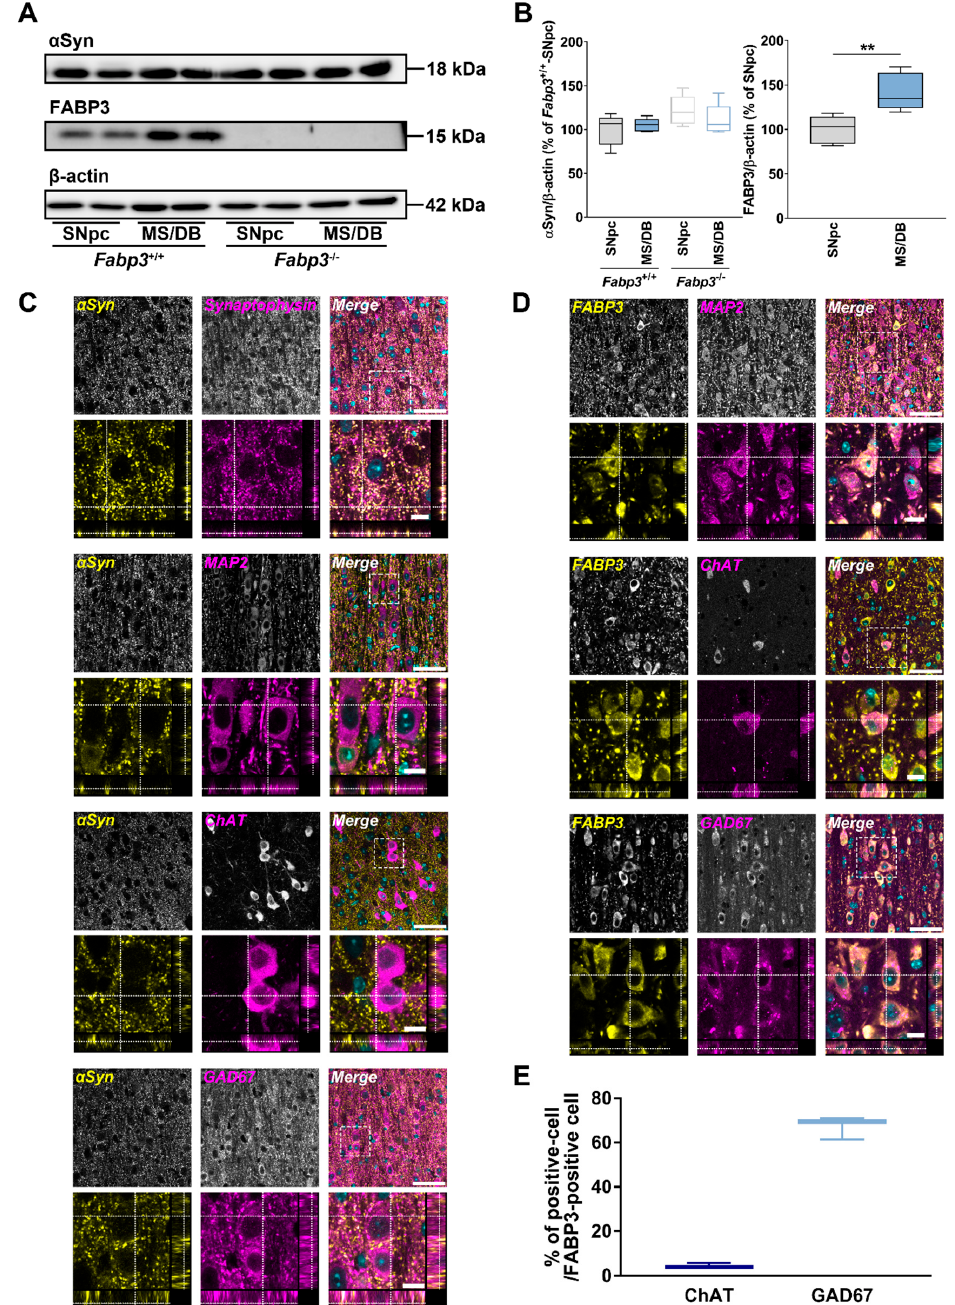
Figure 5. Properties of expression levels and the localization of endogenous α Syn and FABP3 in the MS/DB. ( A ) Representative images of blots probed with anti- α Syn and FABP3 antibodies detected in lysates of substantia nigra pars compacta (SNpc) and MS/DB from naïve Fabp3 +/+ and Fabp3 − / − mice. ( B ) Quantitative analyses of the blots. ** p < 0.01 between SNpc and MS/DB from Fabp3 +/+ mice ( n = 5 per group). ( C , D ) Representative images of the localization of endogenous α Syn ( C ) and FABP3 ( D ) in the MS/DB. Sections were probed with anti- α Syn ( C ) or anti-FABP3 ( D ) antibody (yellow) with anti-synaptophysin, microtubule-associated protein 2 (MAP2), ChAT, or GAD67 antibodies (magenta). The lower images of each staining represent the magnification and the orthogonal XZ and YZ planes. Scale bar: 50 (merge) and 10 (magnification) μ m, respectively. Sections were counterstained with 4 ′ ,6-diamidino-2-phenylindole (cyan). ( E ) Quantita- tive analyses of the ratio of ChAT-positive or GAD67-positive cells in FABP3-positive cells in the MS/DB ( n = 3 each).